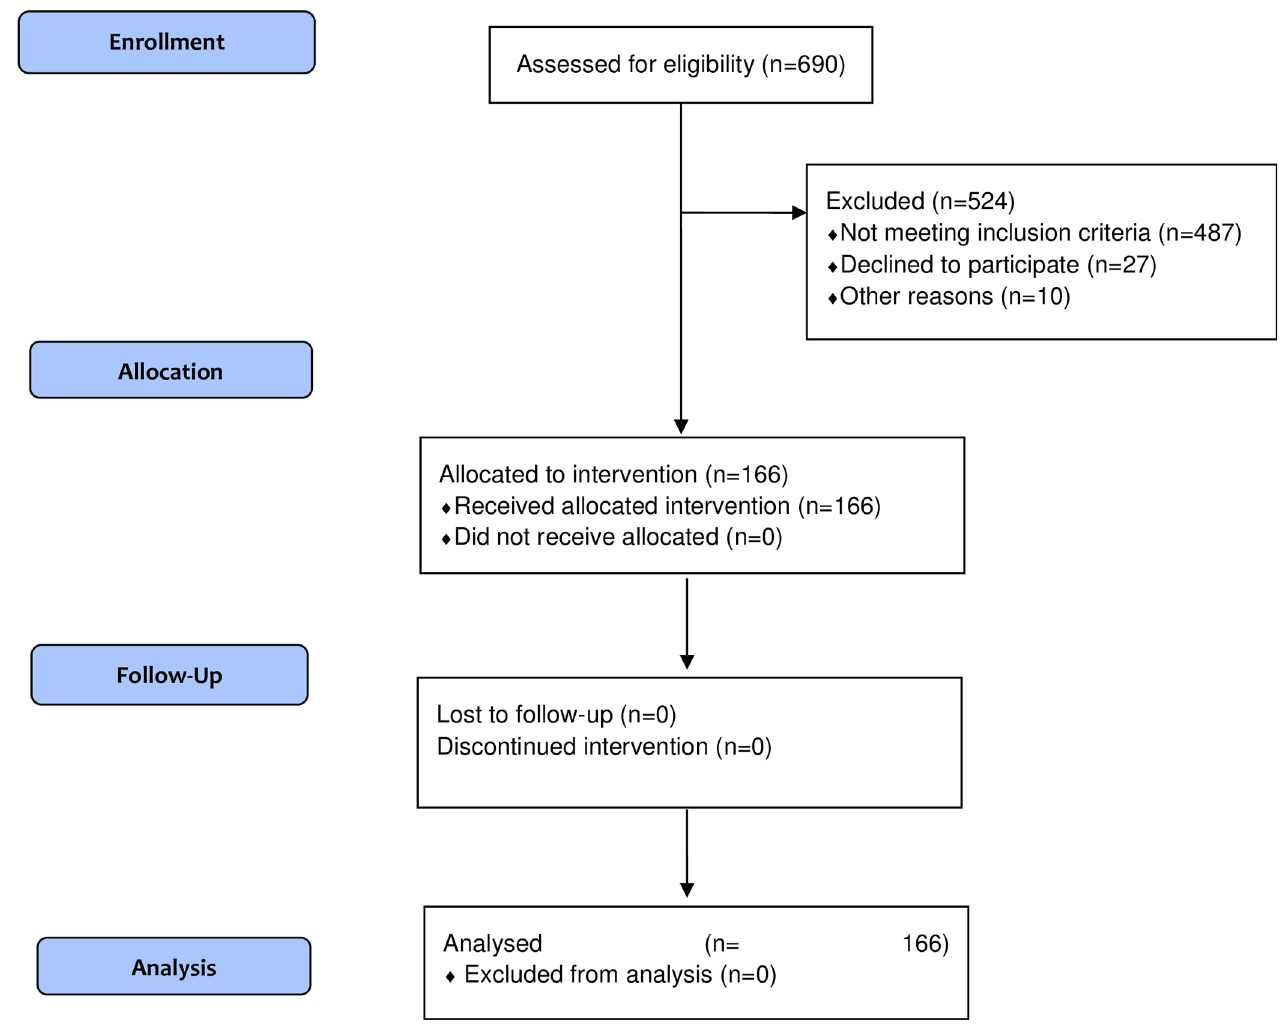
Fig 1. Flow chart diagram of the selection patients in our analysis.